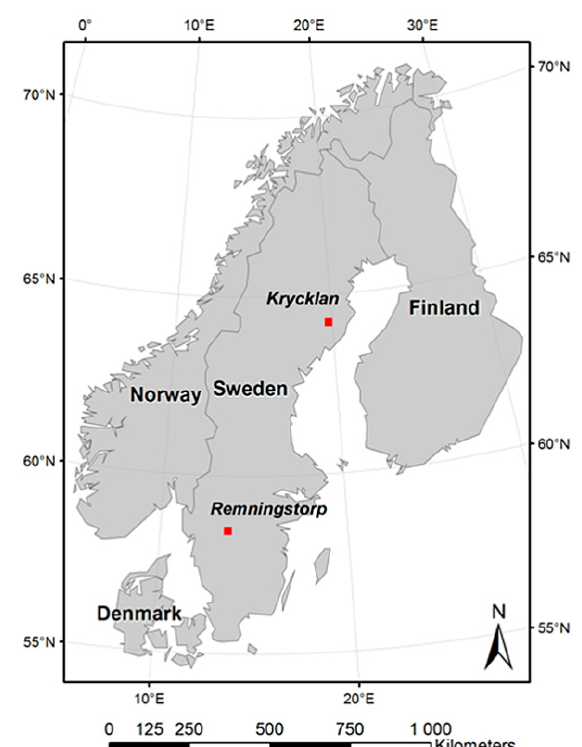
Figure 1. Map of Sweden showing the location of the test sites of Remningstorp and Krycklan.